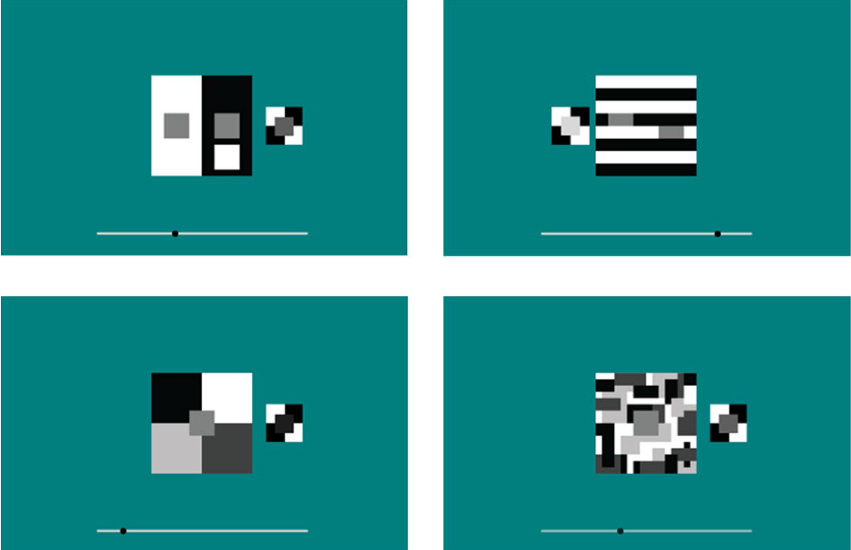
Figure 3. Appearance of 4 screens in our online experiment; different position of the patch signals which target should be matched (left or right, top row), and different position of the bottom slider produces different gray value of the matching patch on the checkerboard background (http:// sunci cazdr avkov ic. com/ Exper iments/ Pedja/ Clana